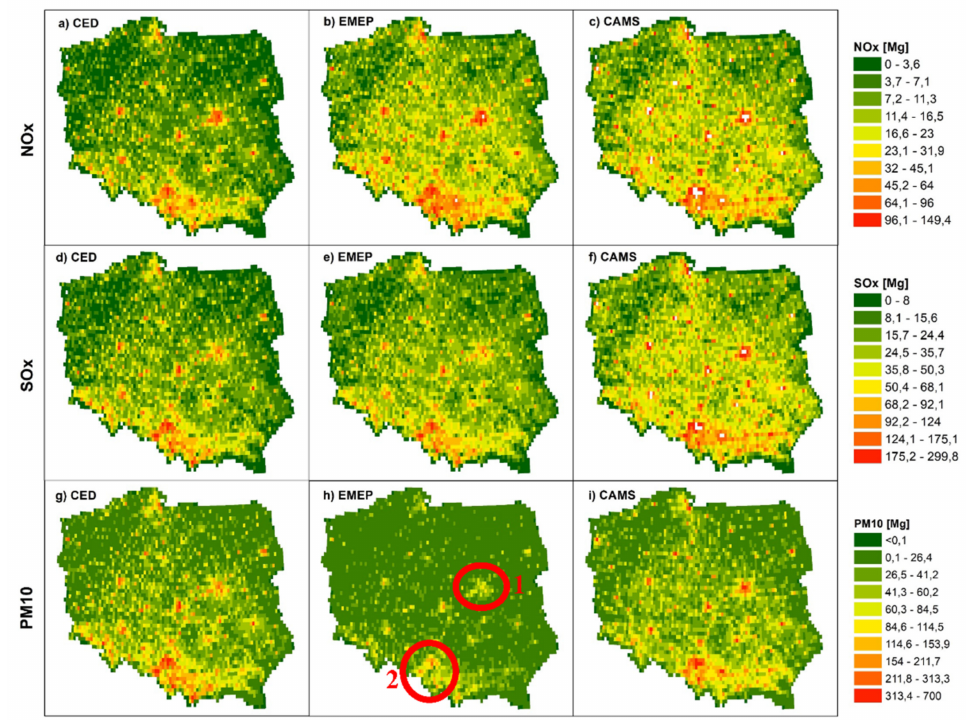
Figure 2. Annual emission per cell of NOx ( a – c ), SOx ( d – f ), and PM 10 ( g – i ). White cells indicate values exceeding the color scale. Spatial resolution was unified (0.1